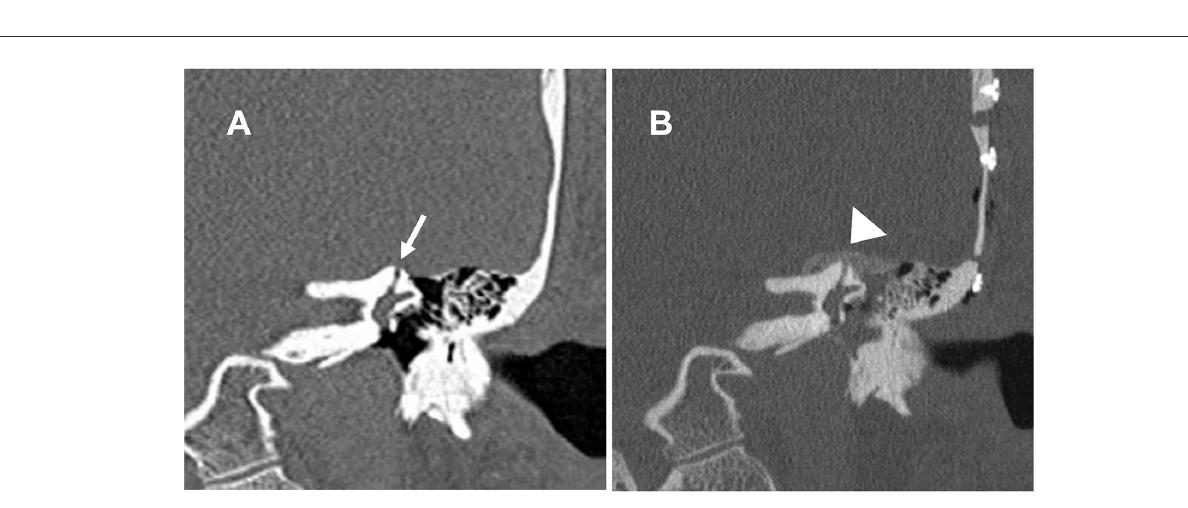
to keep it in place. The craniotomy is closed using four titanium double-Y-shaped plates (Supplementary Video 2). The temporalis muscle and the skin are approximated using absorbable